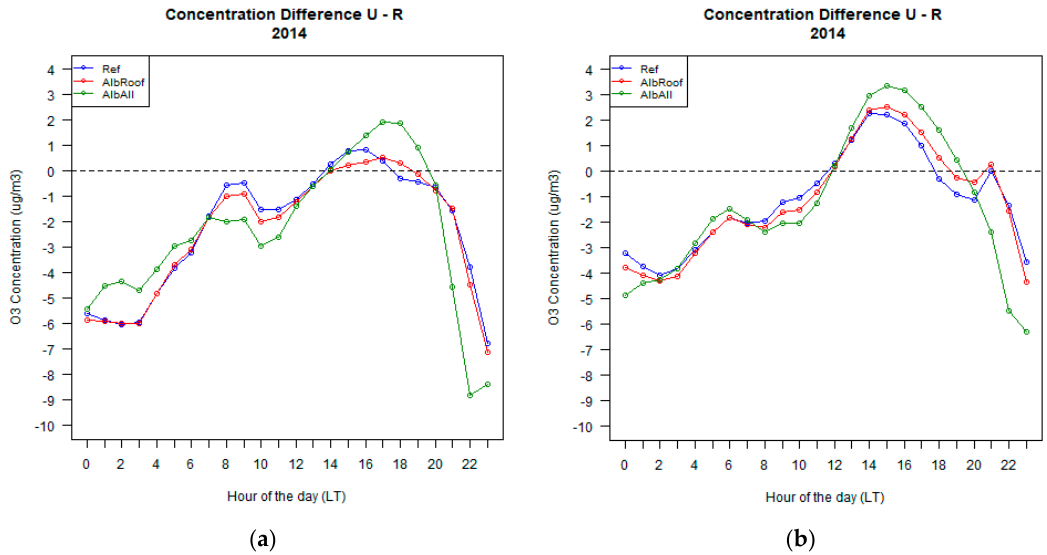
Figure 8. Same as Figure 3, but for ozone concentration: ( a ) Average O 3 concentration difference computed over the mixed forest land use (Rural) category in Figure 1; ( b ) Average O 3 concentration difference computed over the croplands land use (Suburban) category in Figure 1.